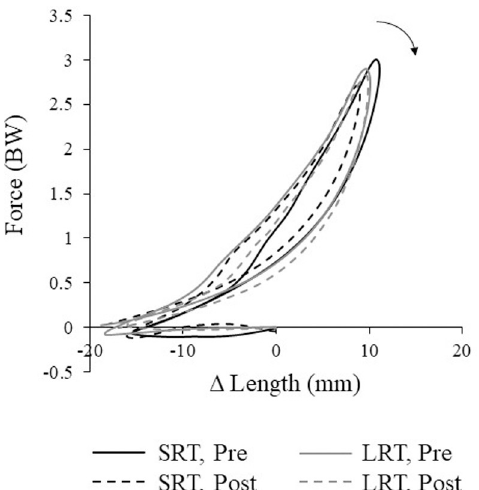
Fig 4. Tendon work-loop, normalized to unit length at heel strike and body weight (BW) before (solid) and after (dashed) training protocols. Arrow depicts loop direction.